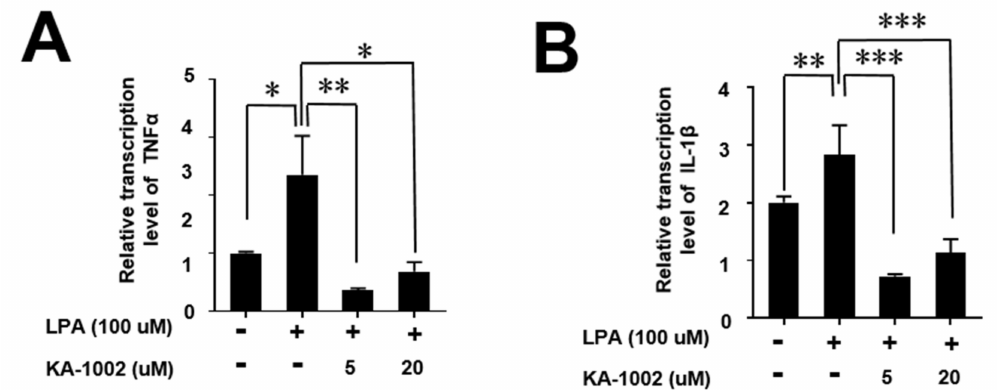
Figure 5. Inhibitory e ff ects of KA-1002 on the production of LPA-induced (A) TNF α and (B) IL-1 β production from EBTr cells. The cells were exposed to KA-1002 at 5 and 20 µ M in the presence of 100 µ M of LPA for 18 hours and inhibition rates were calculated by comparing the corresponding production of respective cytokines from the LPA-untreated control. Pooled results are shown from three independent experiments. * p < 0.05, ** p < 0.01, or *** p < 0.001 indicate significances compared to the LPA-treated group according to two-tailed unpaired Student’s t-testing. Error bars denote standard